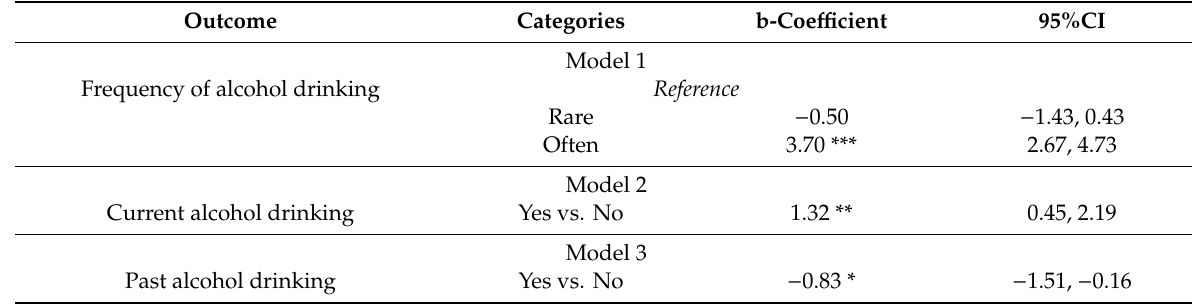
Table 2. Results from multiple linear regression models that evaluated the association between healthy ageing and the alcohol drinking, among the n = 135,440 ATHLOS study